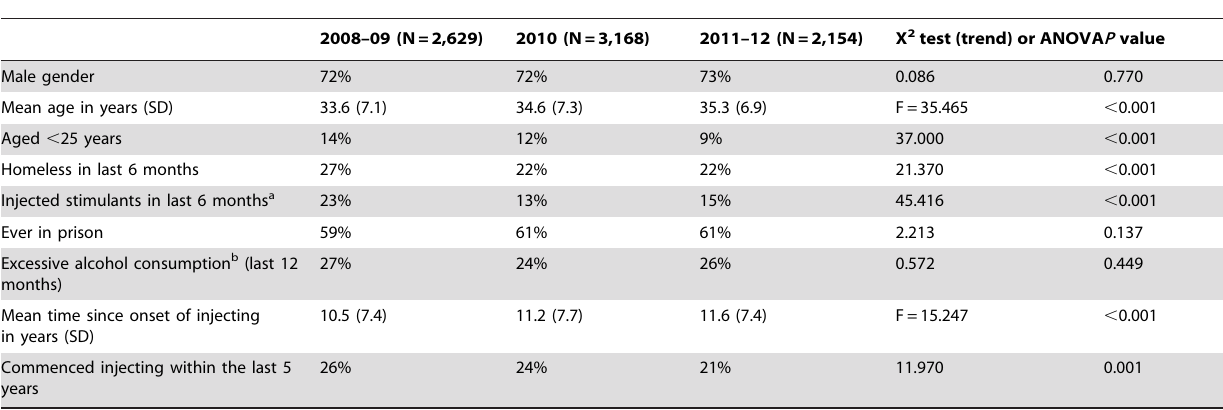
Table 1. Demographic and other characteristics of study population, by